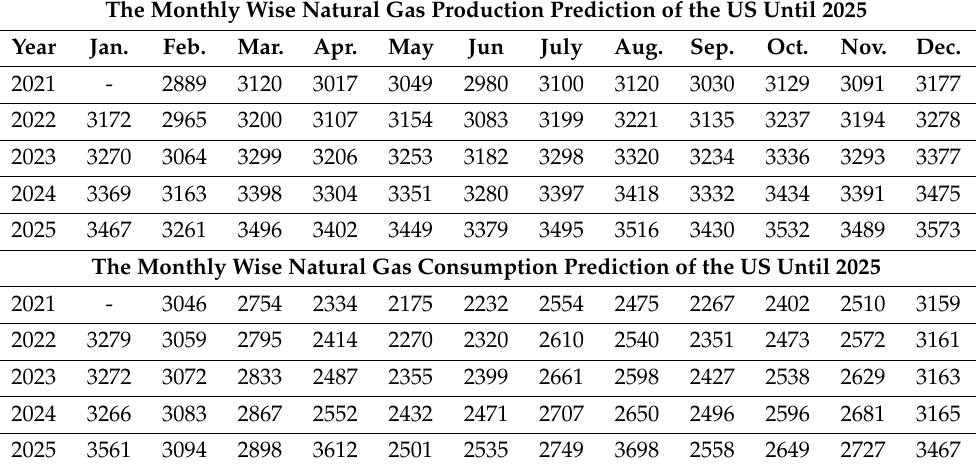
Table 8. Forecast values on the monthly wise natural gas production and consumption of the United States. The Monthly Wise Natural Gas Production Prediction of the US Until